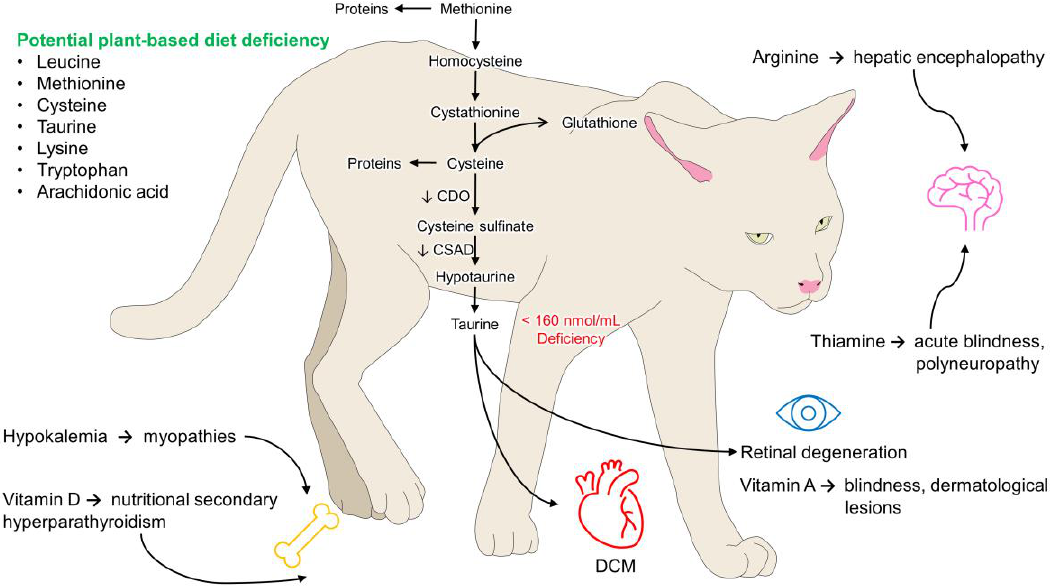
Figure 11. Potential adverse effects of nutritional deficits in vegan diets for domestic cats based on principles of nutritional physiology. Amino acid deficits are often reported in the analytical compo- sition of vegan diets. Taurine, an amino acid required for correct cardiac and visual functioning, is essential to prevent retinal degeneration of DCM. Other deficiencies, such as arginine, vitamin D, vitamin A, or thiamine, can cause hepatic encephalopathy, secondary nutritional hyperparathyroidism, blindness, or polyneuropathies, respectively. DCM: dilated cardiomyopathy.